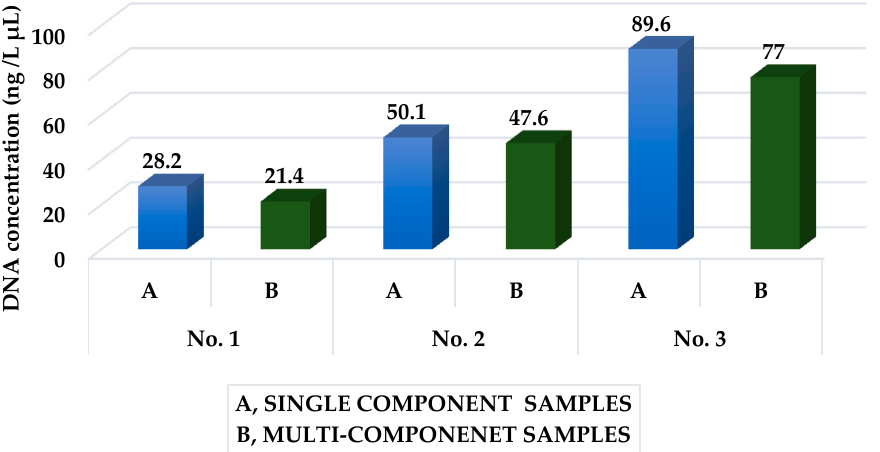
Figure 2. DNA concentration isolated by isolation procedure no. 1, 2 and 3.